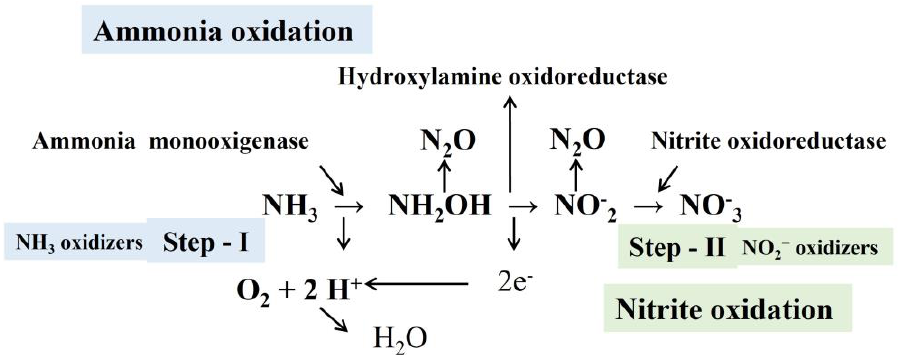
Figure 1. Reaction mechanism of ammonia − nitrite oxidation used in Recirculatory Aquaculture System (RAS).